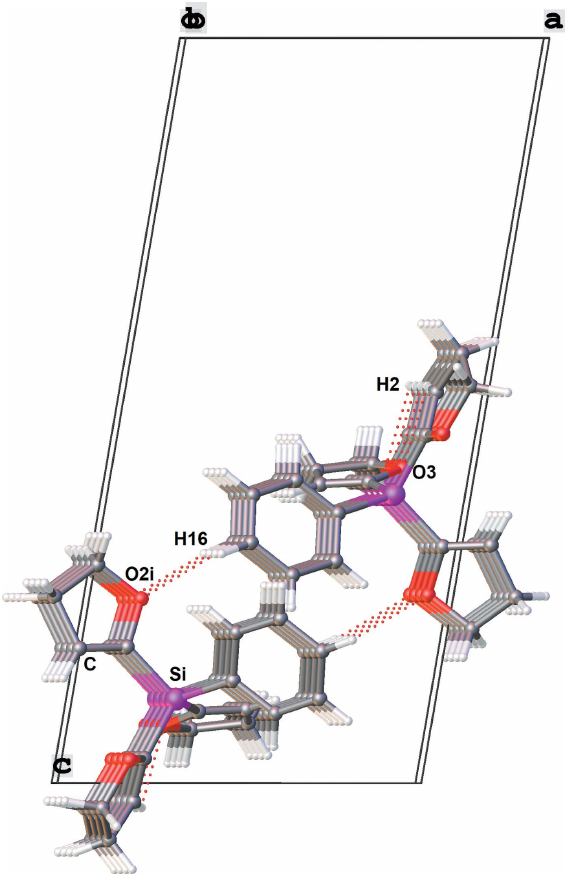
, y + 1 , (cid:5) z + 1 ; (ii) (cid:5) x + 1 , y (cid:5) 1 , 2 2 2 2 2